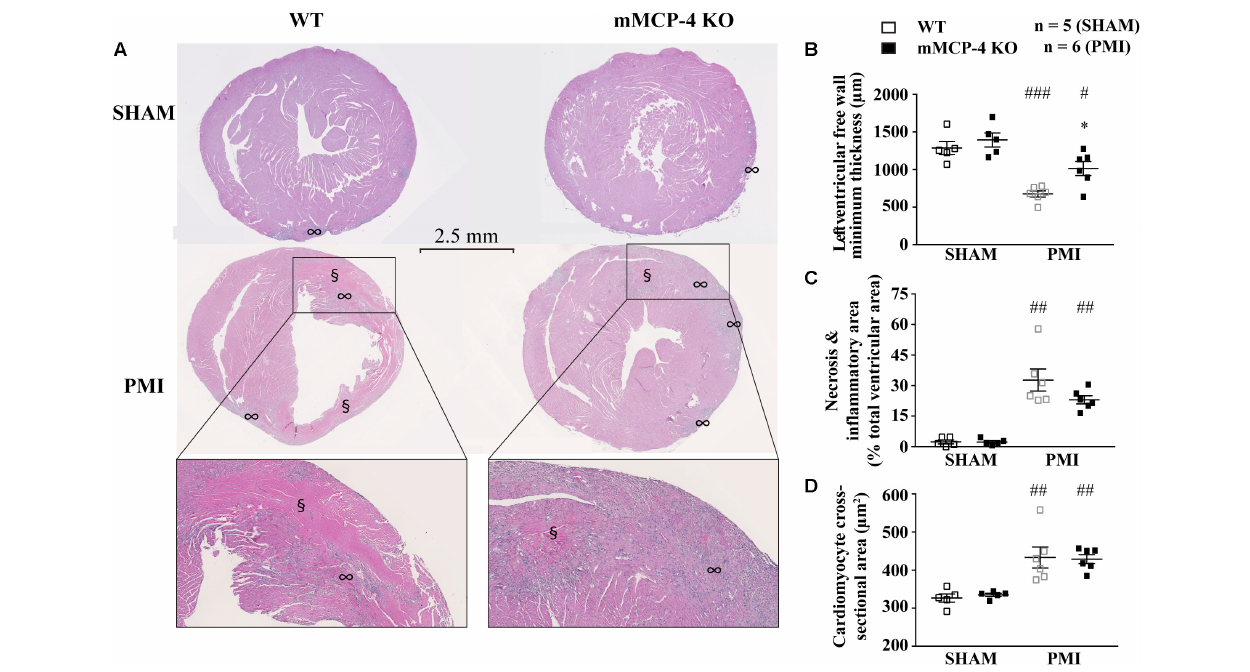
FIGURE 3 | Representative H&E staining of heart sections 3 days following LAD coronary artery ligation (A) . § notes eosinophilia sites, ∞ marks inflammatory cell invasion sites. The minimal thickness at the infarct site (B) , eosinophilic and inflammatory regions (C) and cardiomyocyte cross-sectional area (D) were measured from the same images and quantified. (#: PMI vs. SHAM, ∗ : mMCP-4 KO vs. WT, one-way ANOVA with multiple comparisons Holms-Šidak post-test).